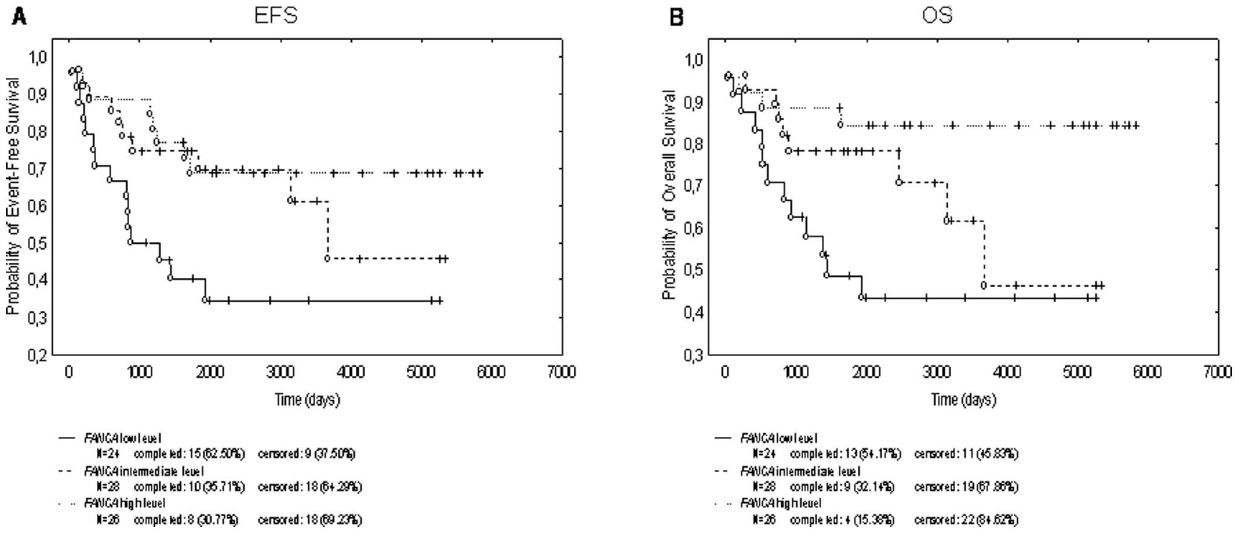
Figure 1. Kaplan-Meier estimates for event-free survival (panel A) and overall survival (panel B) in TNBC patients stratifies by the different level of FANCA expression (univariate analysis, categorization based on tertiles).